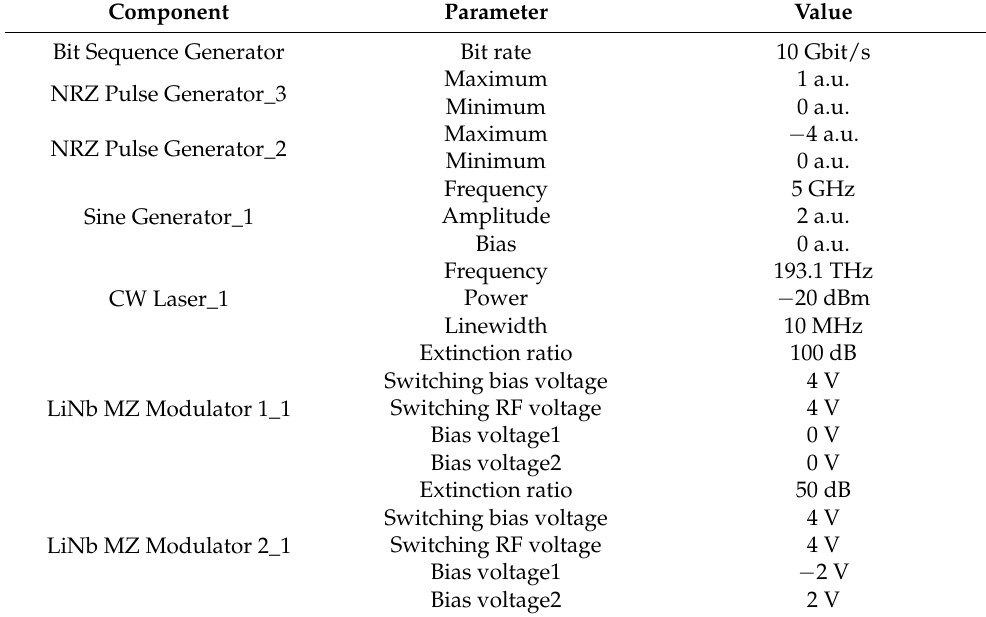
Table 2. Parameters design of a